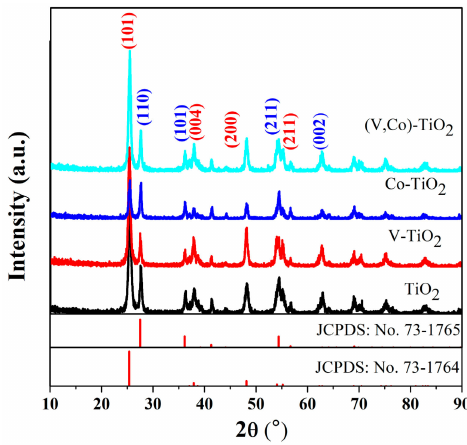
Figure 1. XRD patterns of TiO 2 , V–TiO 2 , Co–TiO 2 , and (V,Co)–TiO 2 samples. Table 1. Anatase and rutile content of TiO 2 , V–TiO 2 , Co–TiO 2 , and (V,Co)–TiO 2 samples. Samples with Different Doping